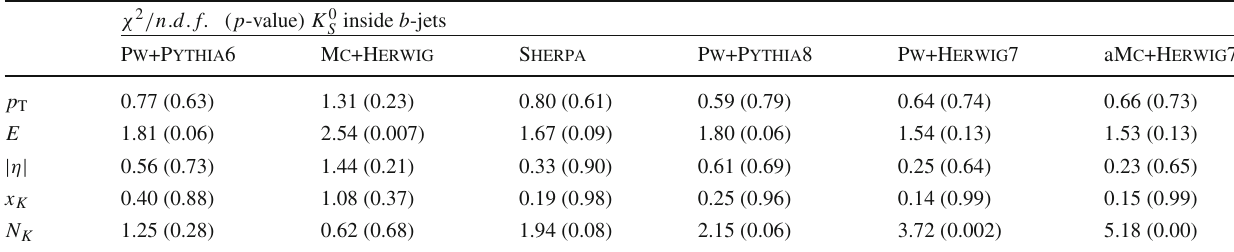
Table 7 Values of the χ 2 per degree of freedom and their corresponding p -values, for K 0 MC@NLO + Herwig , Sherpa , Powheg + Pythia8 , Powheg + Herwig7 and a MC@NLO + Herwig7 predictions